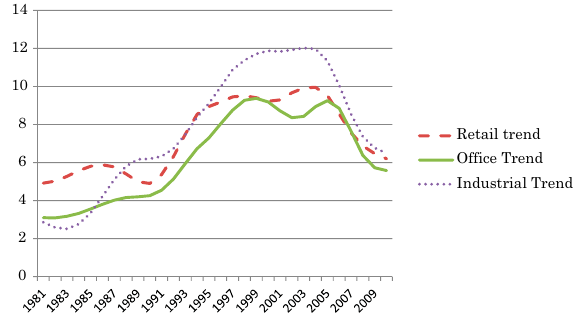
fig. 8. Trends in purchases as a percentage of capital value of the stock based on the HP filter ( λ = 6.25)